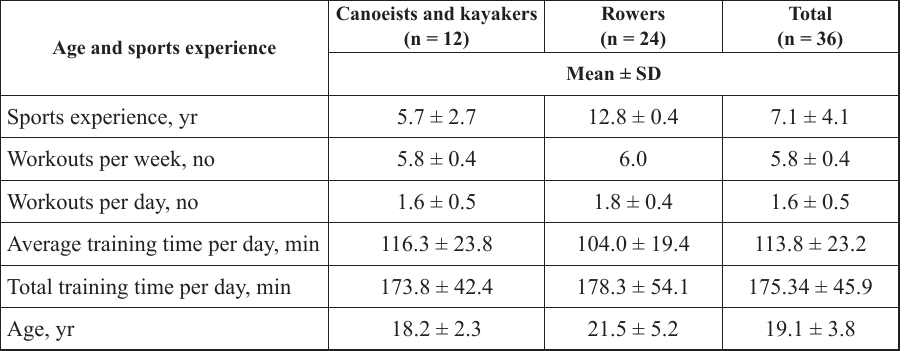
Table 1. Age and sports experience of Lithuanian Olympic team canoeists, kayakers and